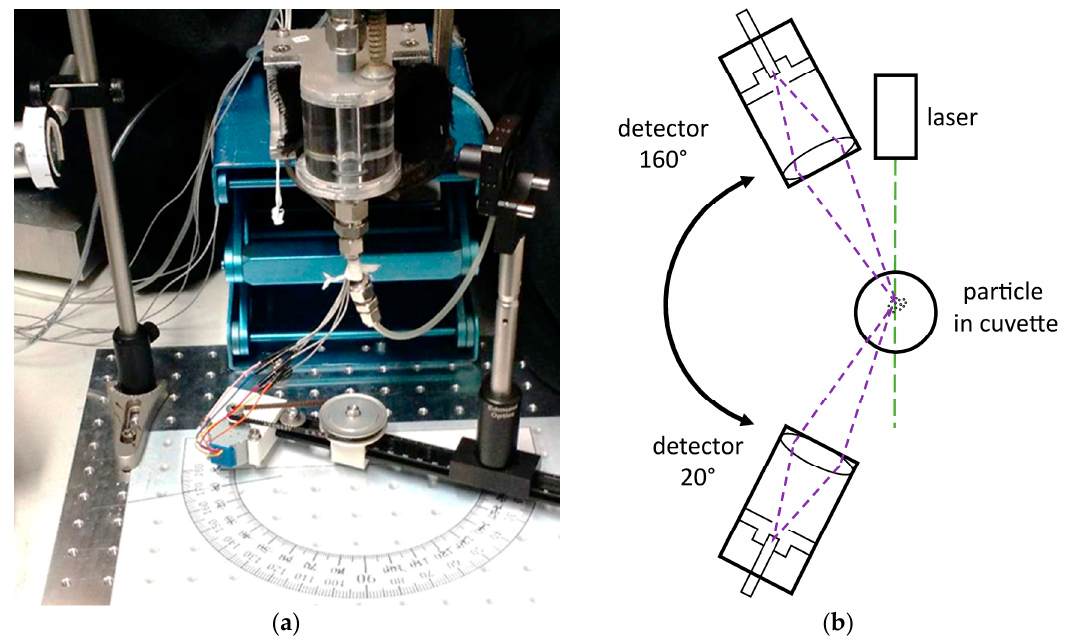
Figure 6. ( a ) Adjustment of cuvette; ( b ) adjustment of detector.